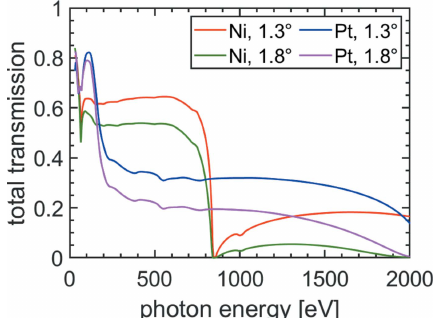
Figure 2 Calculated total transmission of the mirror coatings used in the different beam paths based on CXRO (Henke et al. , 1993), assuming a FEL beam p -polarized in the horizontal plane. The grazing incidence angle # v = 1.8 (cid:2) is associated with the variable beam path, and a grazing incidence angle of # f = 1.3 (cid:2) is applied in the fixed beam path. Note that only the same type of mirror coating [Ni (red and green) or Pt (blue and magenta)] can be chosen